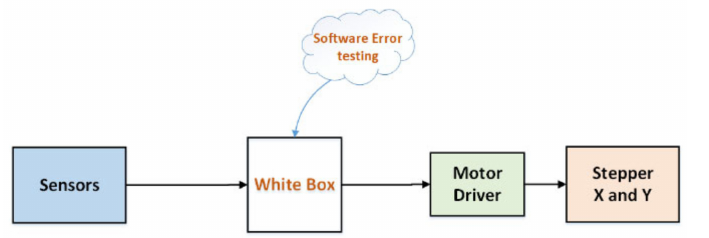
Figure 2. White-box software testing (WBST) block diagram for offline software testing.